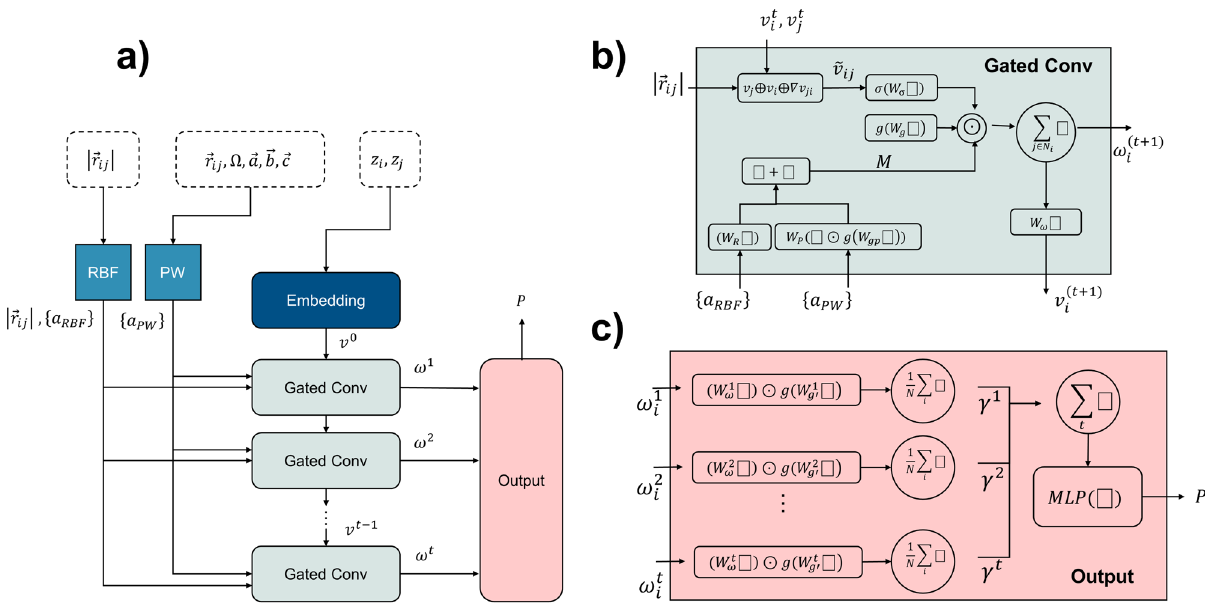
Fig. 3 Model framework. a Model architecture, z denotes the atomic number of each atom; Embedding block generates one-hot encoding and implements a linear transformation to adjust the embedding ’ s dimension; a basis (Eq. 11), t is the layer index. b The detailed Gated Graph Convolution block includes the aggregation and updating functions (Eqs. 4 and 5). c the